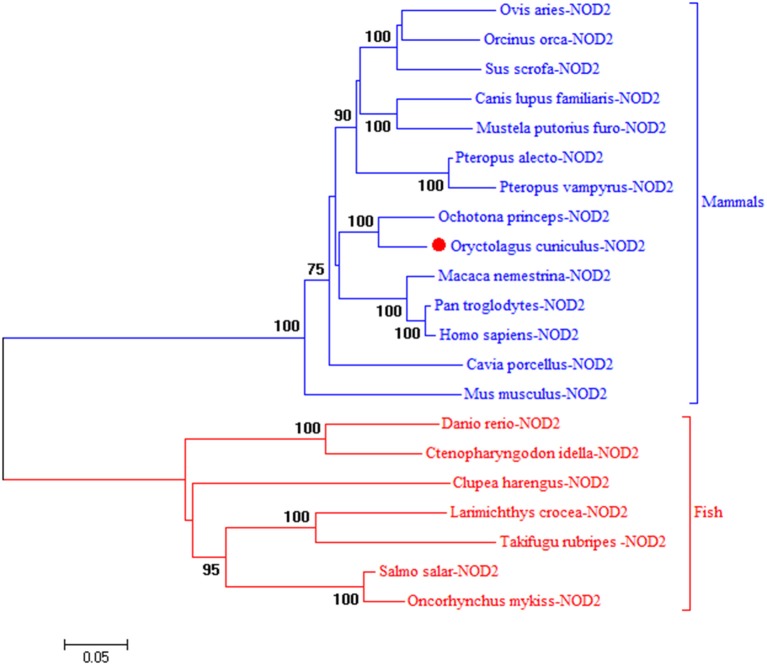
A phylogenic tree based on rNOD2 between Oryctolagus curiculus and other species. A neighbor-joining tree was performed with MEGA 5.0. The tree was bootstrapped 1,000 times and the percentage of the bootstrapped values are shown. The sequences used are: Ovis aries NOD2, XP_014955920.1; Orcinus orca NOD2, XP_004264937.1; Sus scrofa NOD2, BAH24204.1; Canis lupus familiaris NOD2, NP_001273968.1; Mustela putorius furo NOD 2, XP_004744216.1; Pteropus Alecto NOD2, XP_006908812.1; Pteropus vampyrus NOD2, XP_011358488.1; O. princeps NOD2, XP_004584173.1; M. nemestrina NOD2, XP_011757602.1; P. troglodytes NOD2, NP_001098710.2; H. sapiens NOD2, NP_071445.1; Cavia porcellus NOD2, XP_003477732.2; Mus musculus NOD2, AAN84594.1; Danio rerio NOD2, NP_001314973.1; Ctenopharyngodon idella NOD2, ACX71753.1; Clupea harengus NOD2, XP_012682426.1; Larimichthys crocea NOD2, AJF23836.1; Takifugu rubripes NOD2, NP_001035913.1; Salmo salar NOD2, XP_014031576.1; Oncorhynchus mykiss NOD2, NP_001188484.1.